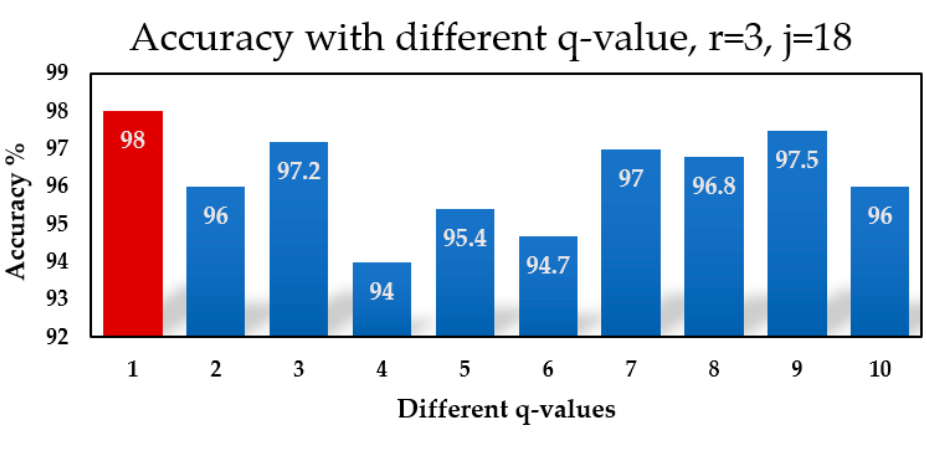
Figure 16. Accuracy with different q-value r = 3, j = 18.